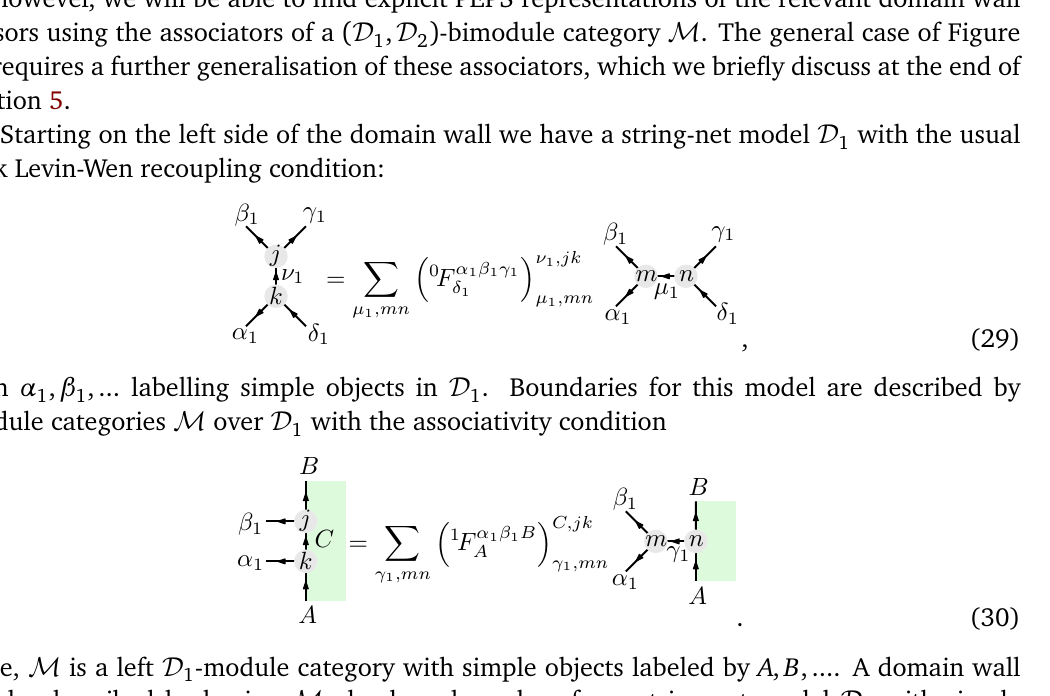
Figure 2: (a) A domain wall between two string-net models D by PEPS and PEPS respectively. (b) For the particular case that M M 1 , D 1 M 2 , D 2 = M , explicit tensors can be constructed in terms of F -symbols of a ( D and M 2 bimodule category M